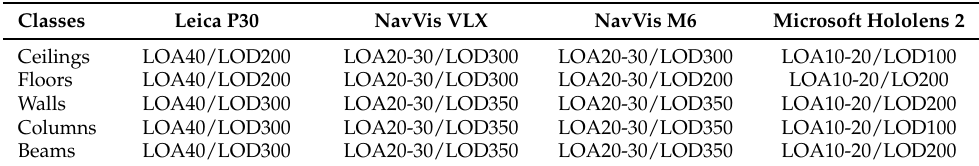
Table 7. Overview of the BIM information that can be extracted from of each scanning technology with regard to the requirements in Table